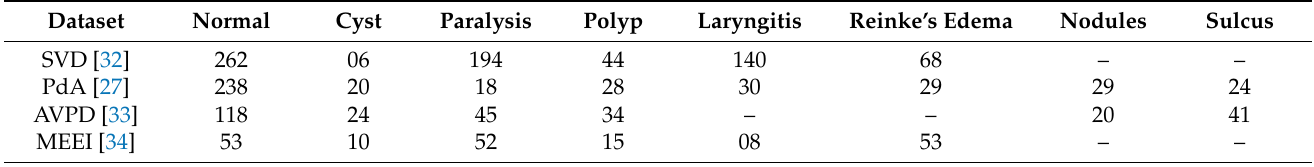
Table 1. Healthy and pathological speakers’ voice (vowel /a/) samples.